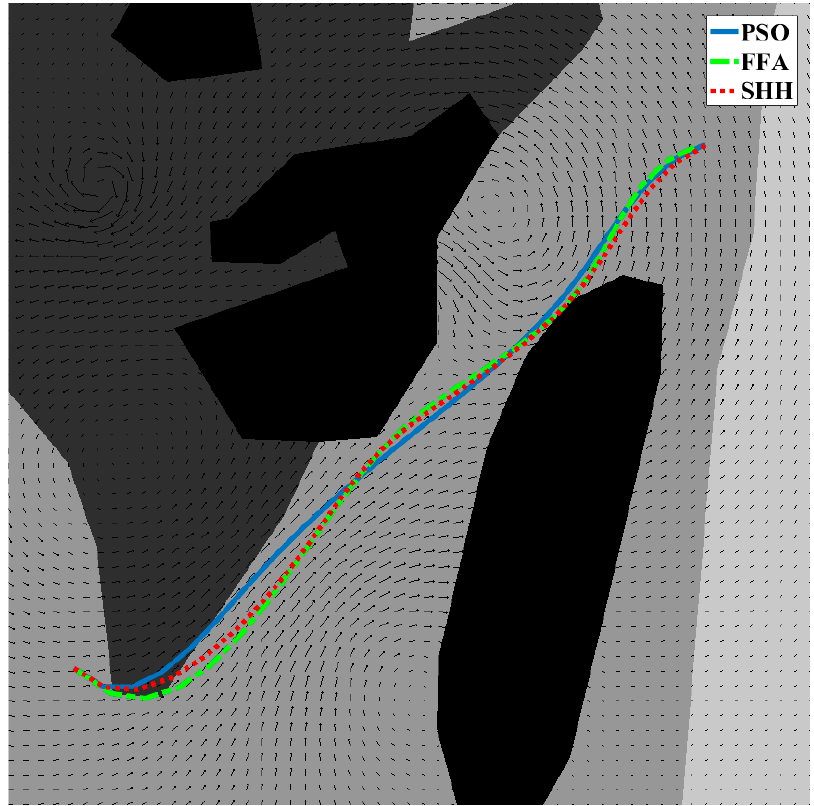
Figure 10. Comparison of the path planning results of PSO, FFA and SHH algorithms in scenario 3.